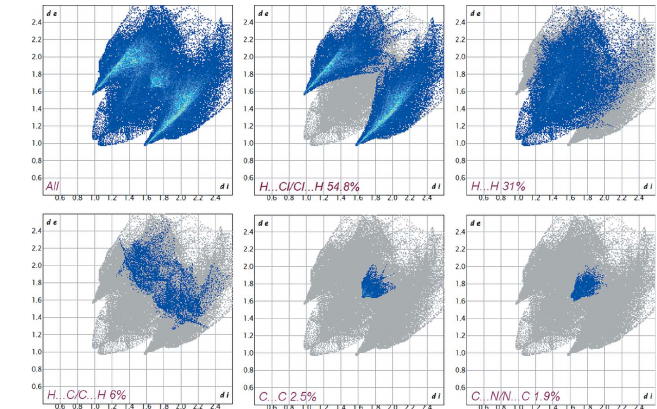
Figure 4 Selected two-dimensional fingerprint plots of compound I where d i and d e represent the distances from the HS to the closest internal and external atoms.